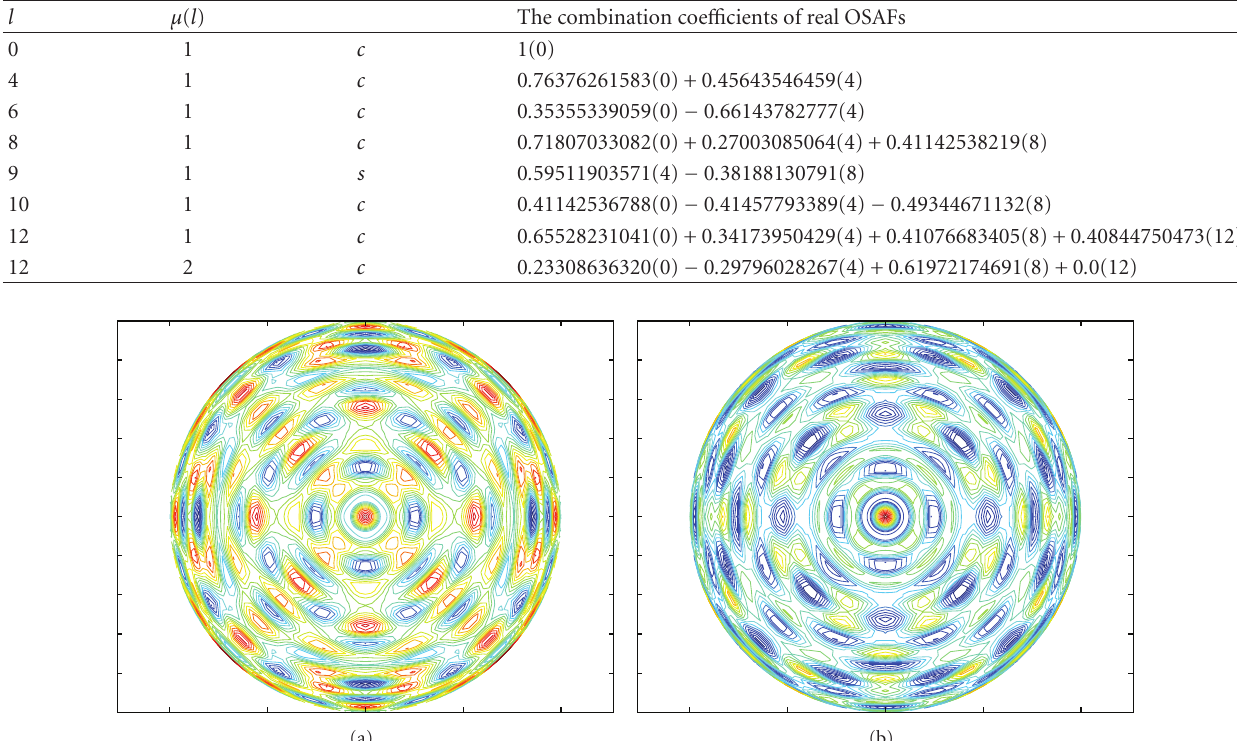
Table 3: The OSAFs of all l ≤ 12.